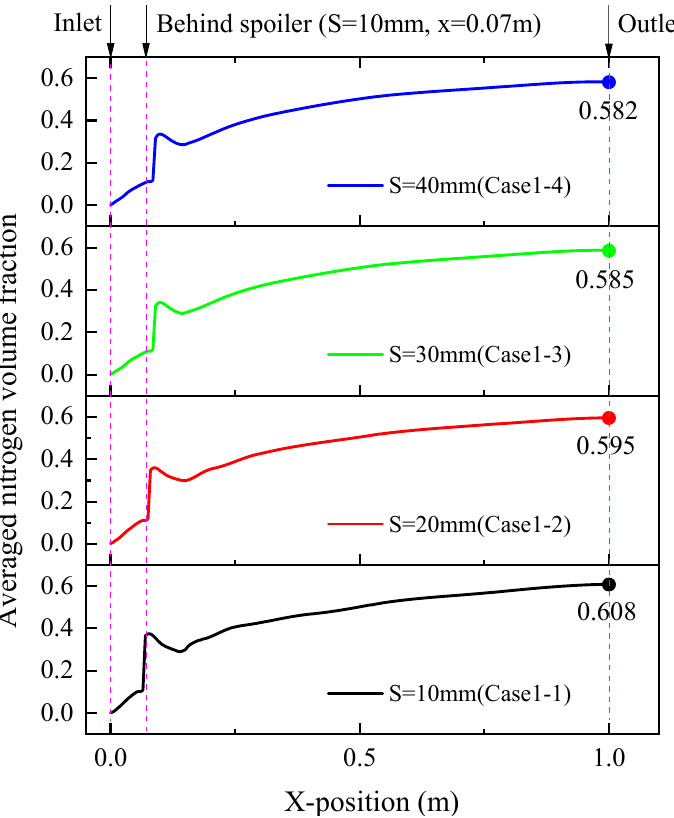
Figure 5. The N 2 volume fraction of cross sections at X-positions with different distances between inlets and cone spoiler (Case 1 series).